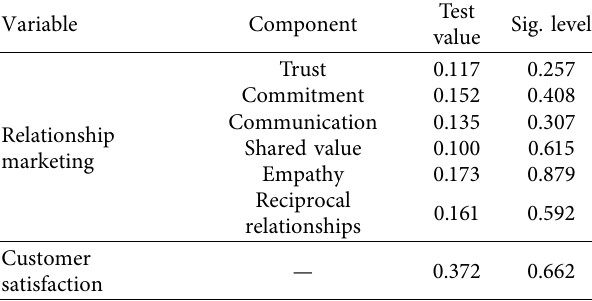
Table 3: Kolmogorov–Smirnov test